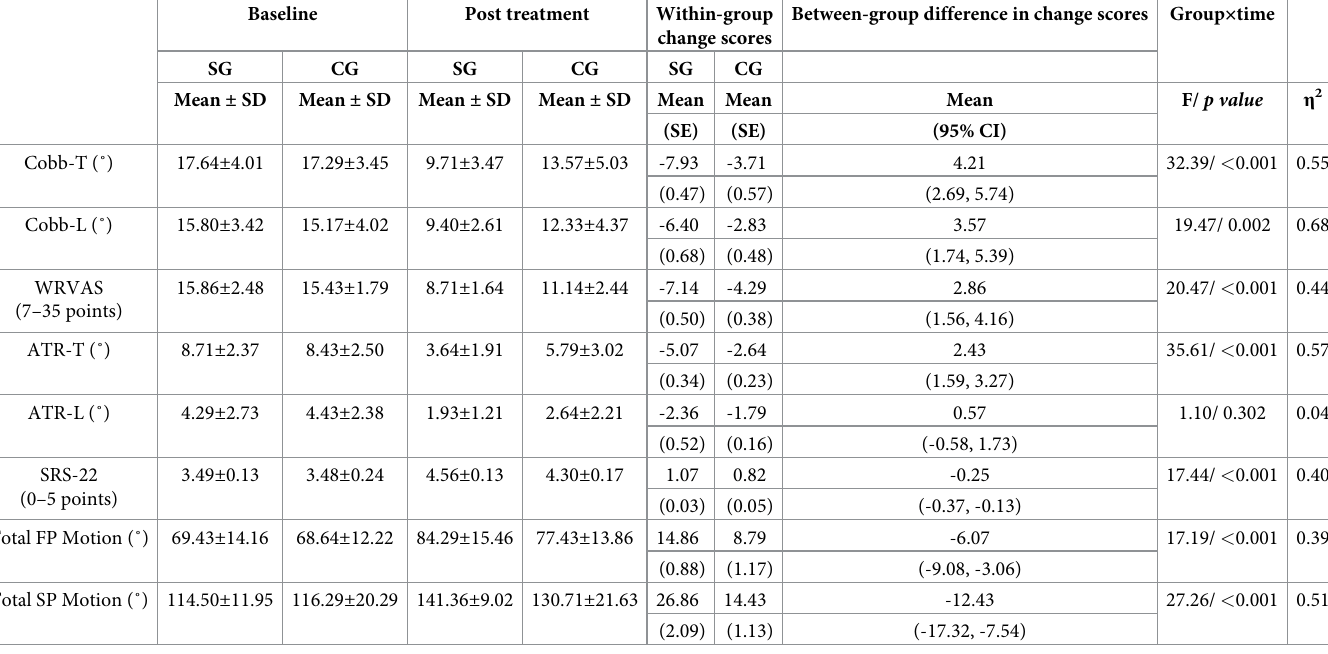
Table 2. Baseline, post-ıntervention and change scores for the Cobb angle, WRVAS, ATR, SRS-22, total FP and SP motion. Baseline